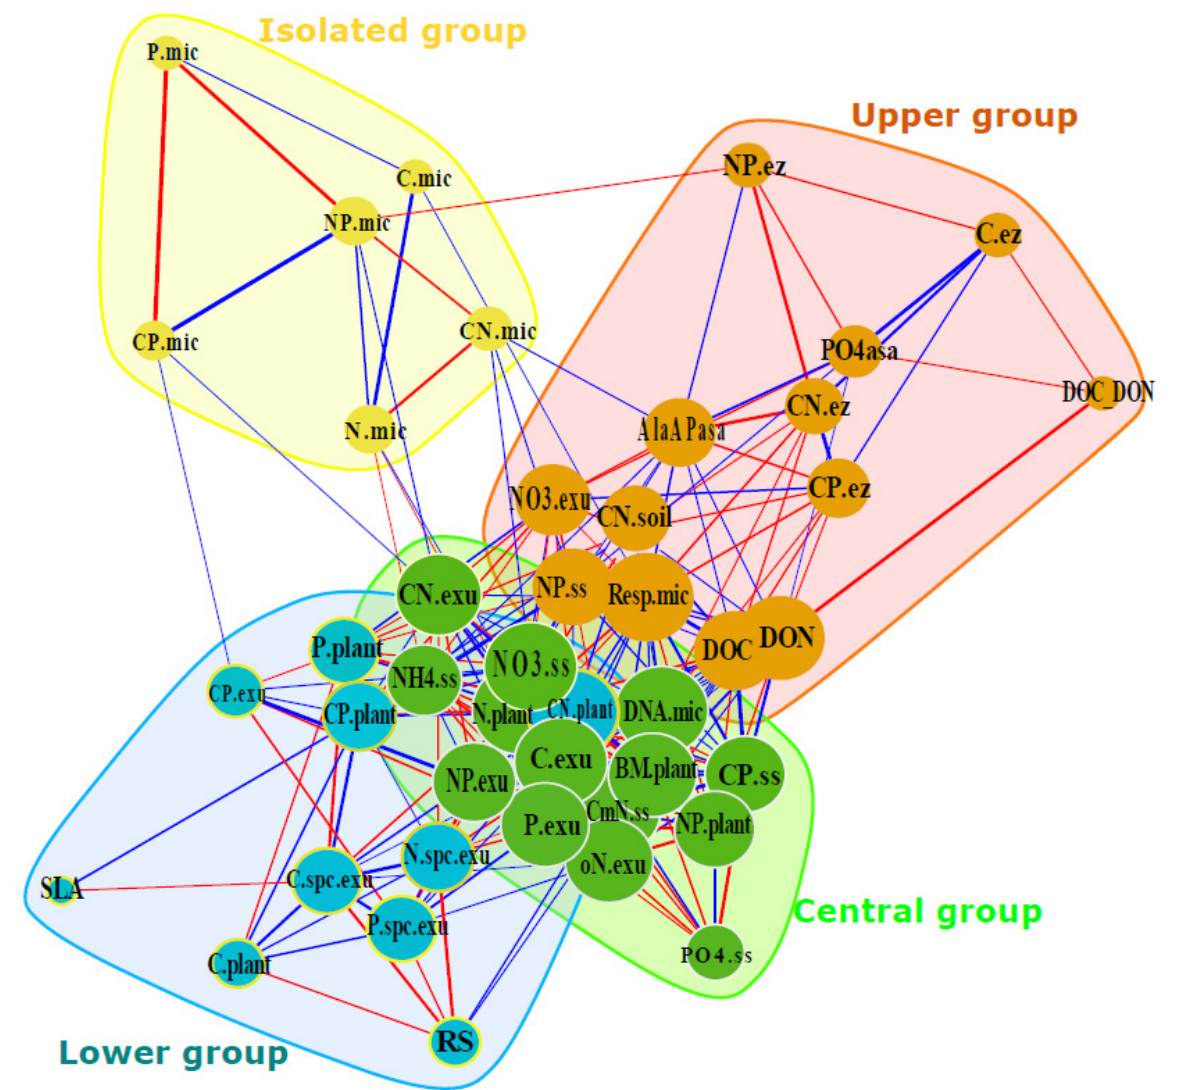
Figure 1. Network of rhizosphere-related variables including soil characteristics, plant functional traits, and indicators of microbial growth and activity. The variables are grouped into 4 groups, which are differently coloured. The size of the circles represents the strength of the variables (number of connections). Lines represent significant correlations between variables (| r | > 0.3, p < 0.05). Line width is proportional to the absolute value of the correlation coefficient and the colour indicates whether they are positive, blue, or negative, red.